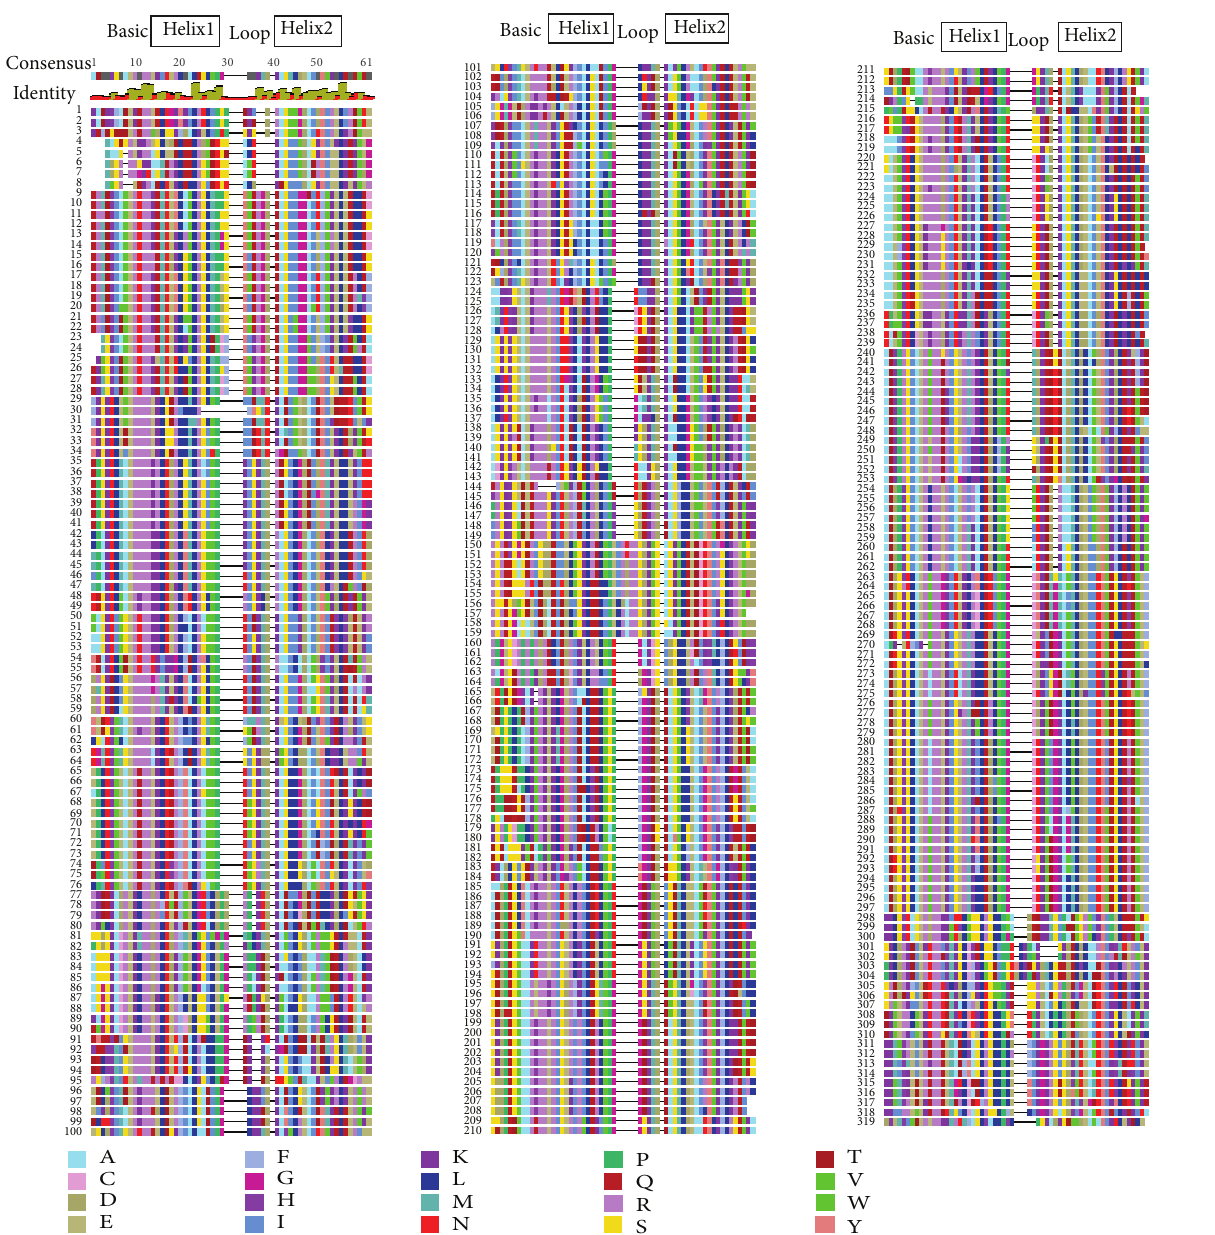
Figure 1: Alignment of the bHLH domain from 319 soybean proteins. The bHLH region was identified using a HLH hidden Markov model and trimmed or extended from soybean predicted proteins to fit the canonical region aligned in this figure and then aligned using a fast Fourier transform algorithm. A color key is used for the 20 amino acid residues. Extent of conservation and a consensus sequence are shown at top left. The basic and helix-loop-helix regions can be seen via the annotations and the color key. The consensus graph indicates 100% conserved residues as green (there are none in this alignment), 30% or more conserved residues as yellow, and less than 30% conserved residues as red. A full text version is available in Additional File